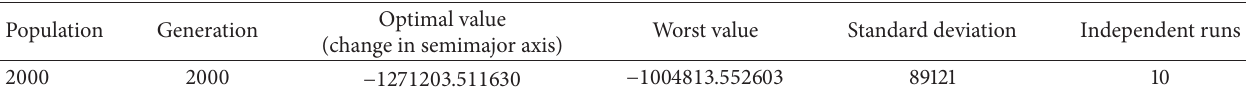
Table 14: Stability of the algorithm.